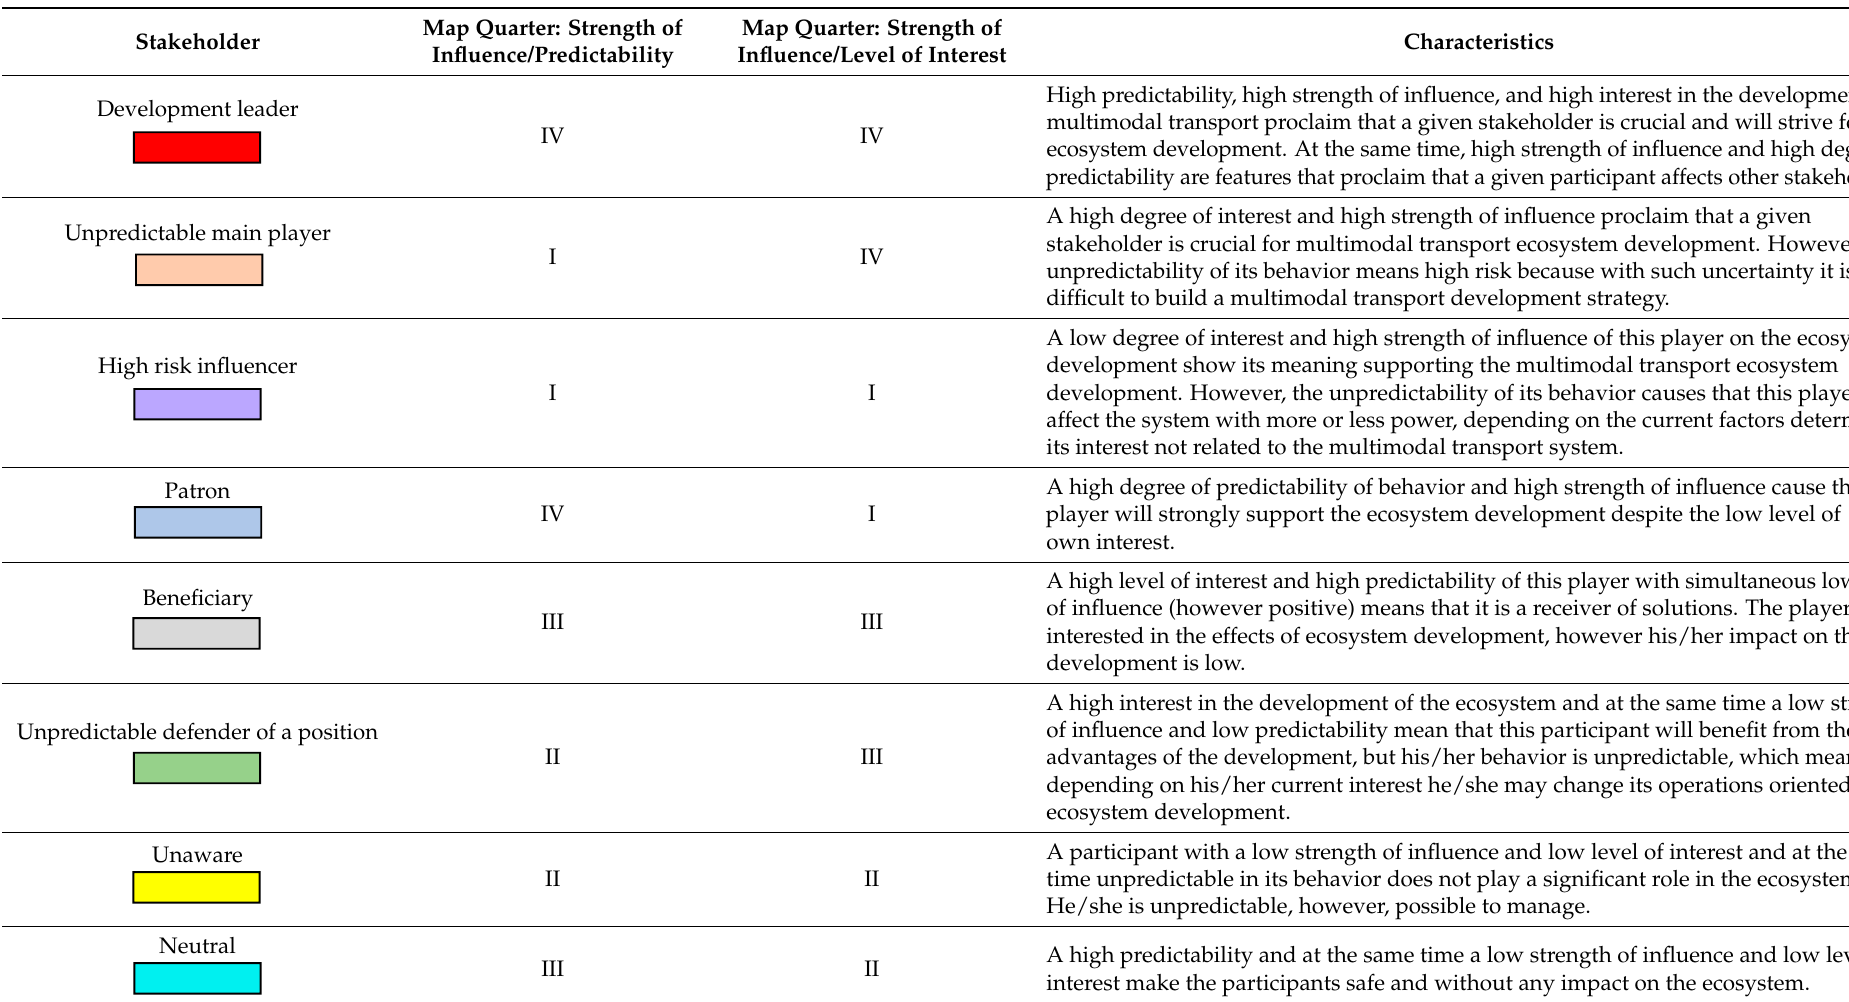
Table 5. Characteristics of the roles of the stakeholders in the multimodal freight transport ecosystem within cross-border area.